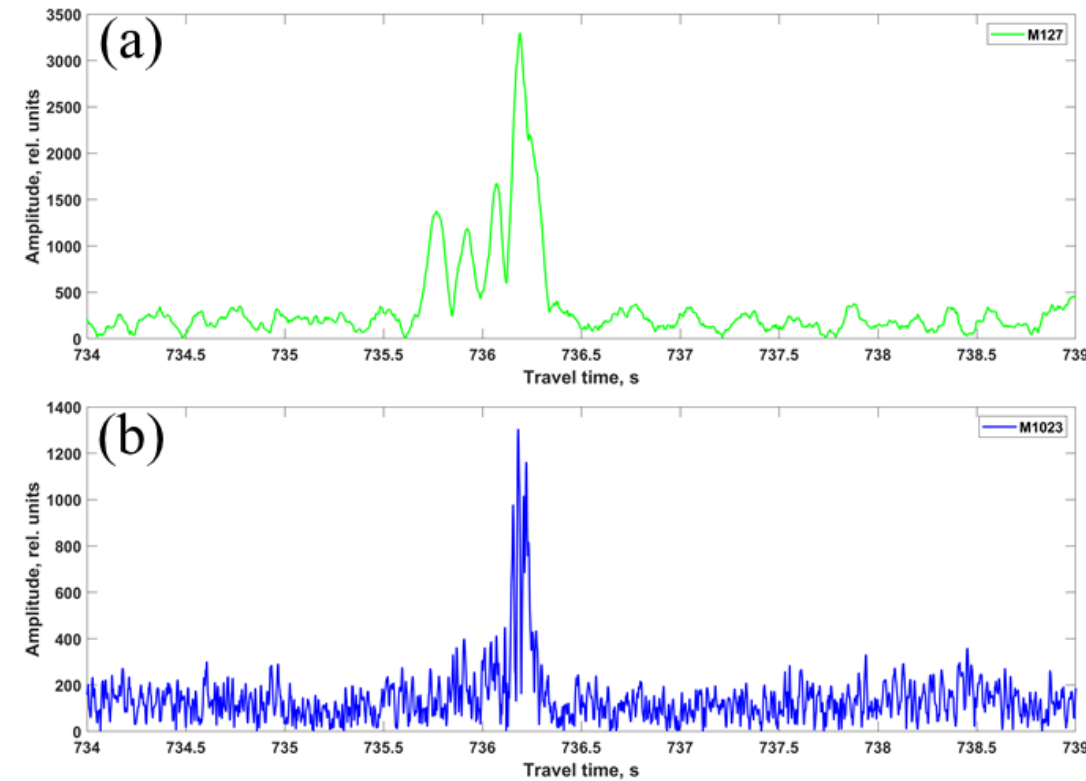
minimal horizontal velocity (1,073,144 m/736.19 s = 1457.7 m/s).